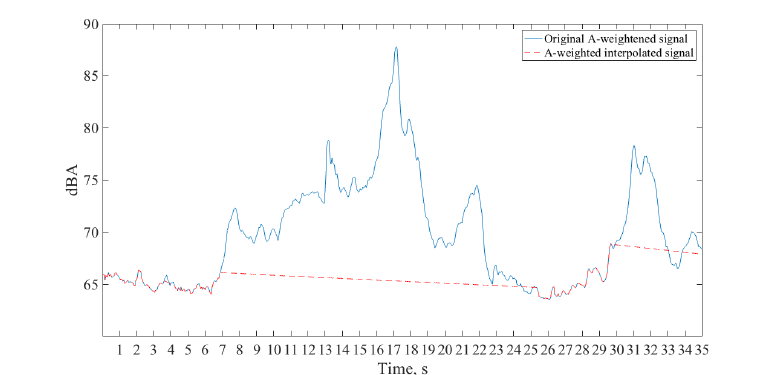
Figure 7. L Aeq of a motorbike showing its previous and posterior available RTN frames used to calculate its